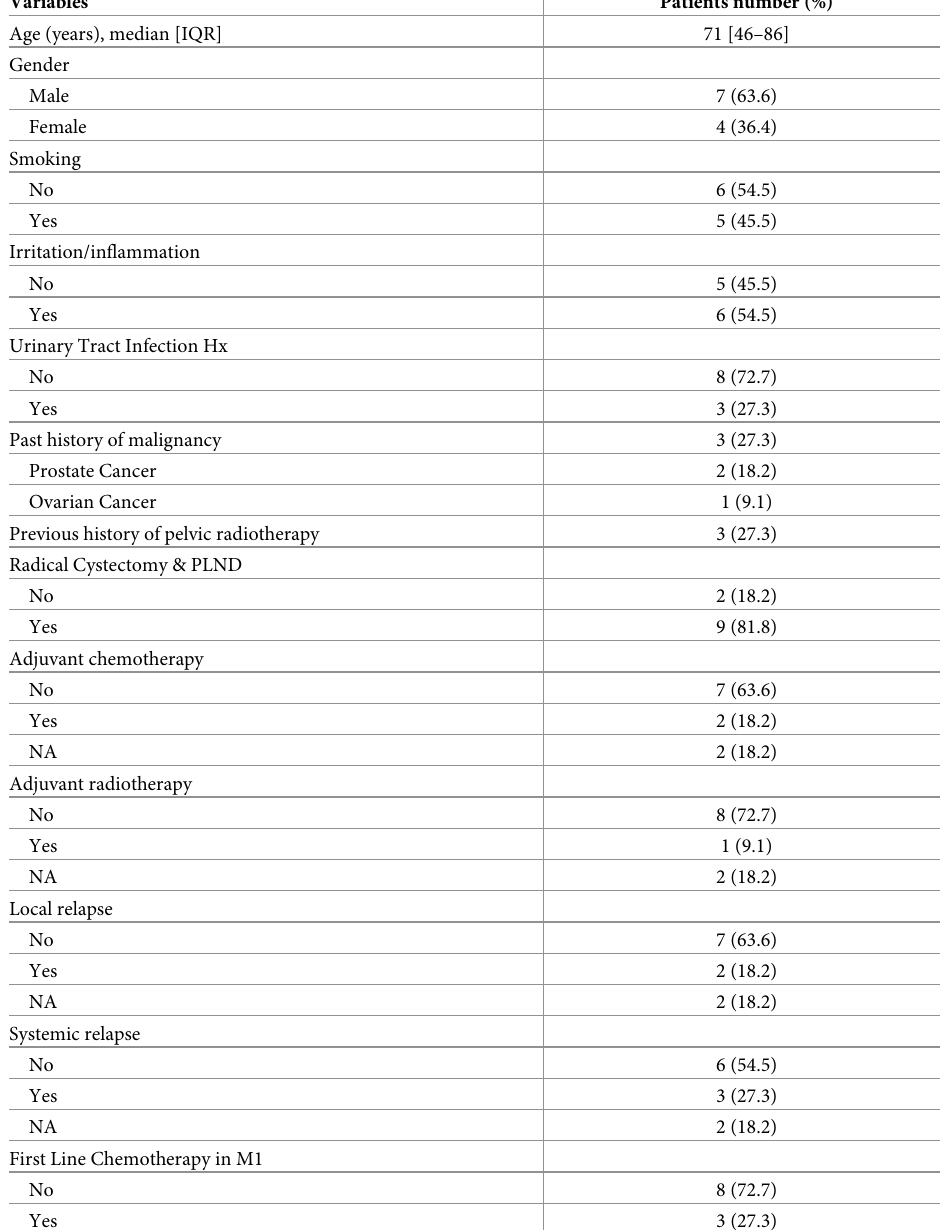
Table 1. Patient demographics, treatment modalities, and outcomes (N = 11).